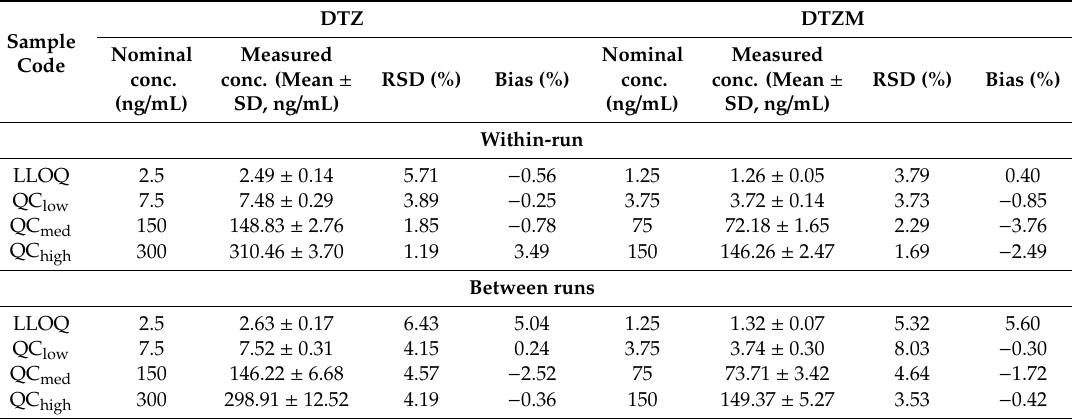
Figure 2. Typical HPLC chromatograms of DTZ and DTZM in plasma: ( a ) Chromatogram of a standard sample containing DTZ (500 ng/mL) and DTZM (250 ng/mL) and internal standard (IS); ( b ) chromatogram of blank plasma; ( c ) chromatogram of a plasma sample obtained from one on the study subjects two hours after drug administration (DTZ—154.4 ng/mL, DTZM—3.9 ng/mL). Table 2. Accuracy and precision data for the determination of diltiazem (DTZ) and desacetyl DTZ (DTZM) in human